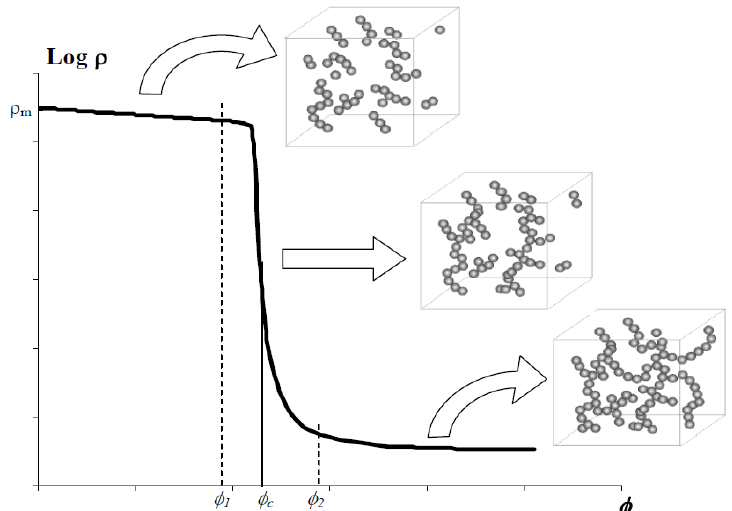
Figure 1. Evolution of electrical resistivity in a composite with volume concentration of electric